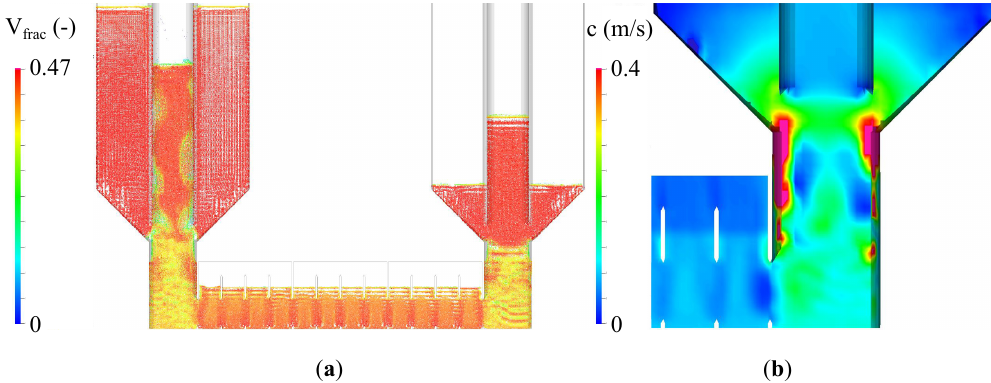
Figure 12. Pipe 1 is bypassed and thus rendered incapable of transport after 74 s and V frac = 1 − ψ ,